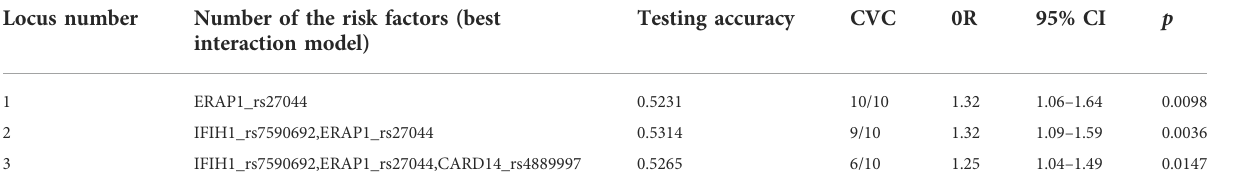
TABLE 2 Best multifactor dimensionality reduction (MDR) interaction models. Locus